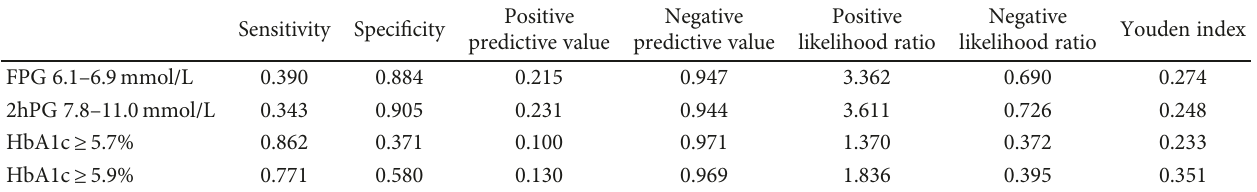
Table 3: Predictive value of the diabetes incidence after 3 years of follow-up according to the di ff erent IGR de fi nitions at baseline. Sensitivity Speci fi city